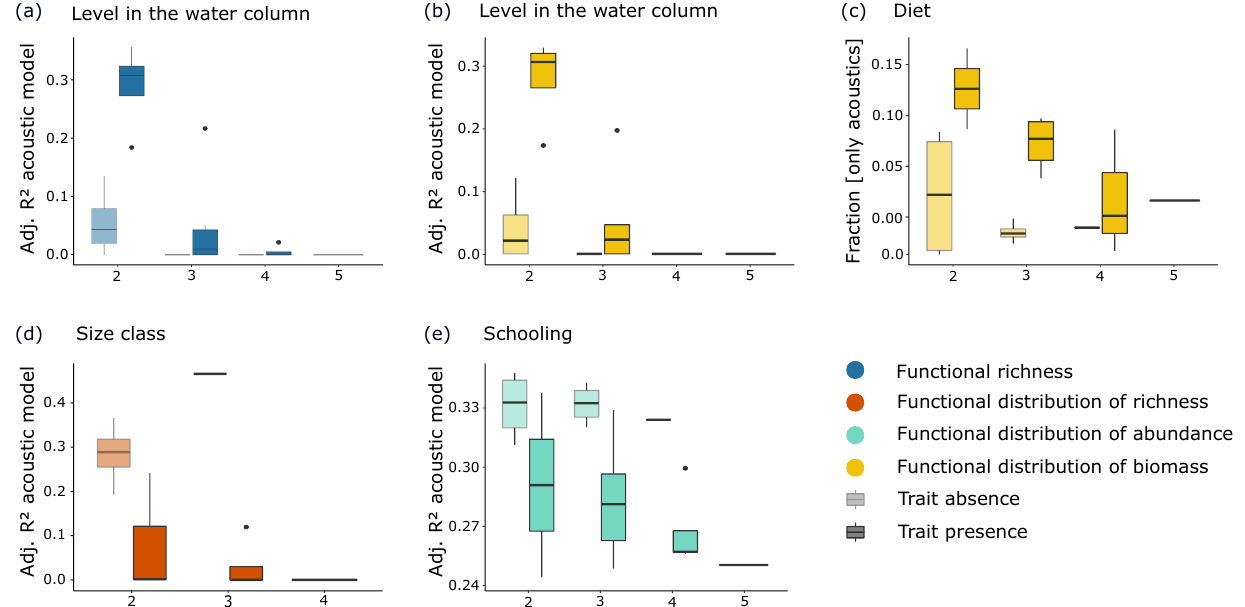
Figure 7. Boxplots representing the effects of the number and identity of traits (considered in FEs construction) on the adjusted R 2 of the acoustic models (or on the fraction only explained by acoustic variables). Over the 40 tests (i.e., 20 tests on adjusted R 2 of the acoustic models and 20 tests on fractions [only acoustics]), we only present the results of the tests for which trait presence effect was significant at p < 0.01. Boxes are darker when trait is present. For example, in Figure 7a under 2 traits, the lightest boxplot represents the dispersion of values for adjusted R 2 of the acoustic models in the cases where 2-trait FEs do not include the level in the water column (i.e., diet-schooling, diet- mobility, size-mobility, mobility-school). On the contrary, the darkest boxplot represents the cases where 2-trait FEs include the level in the water column (i.e., diet-lwater; size-lwater; mobility-lwater;